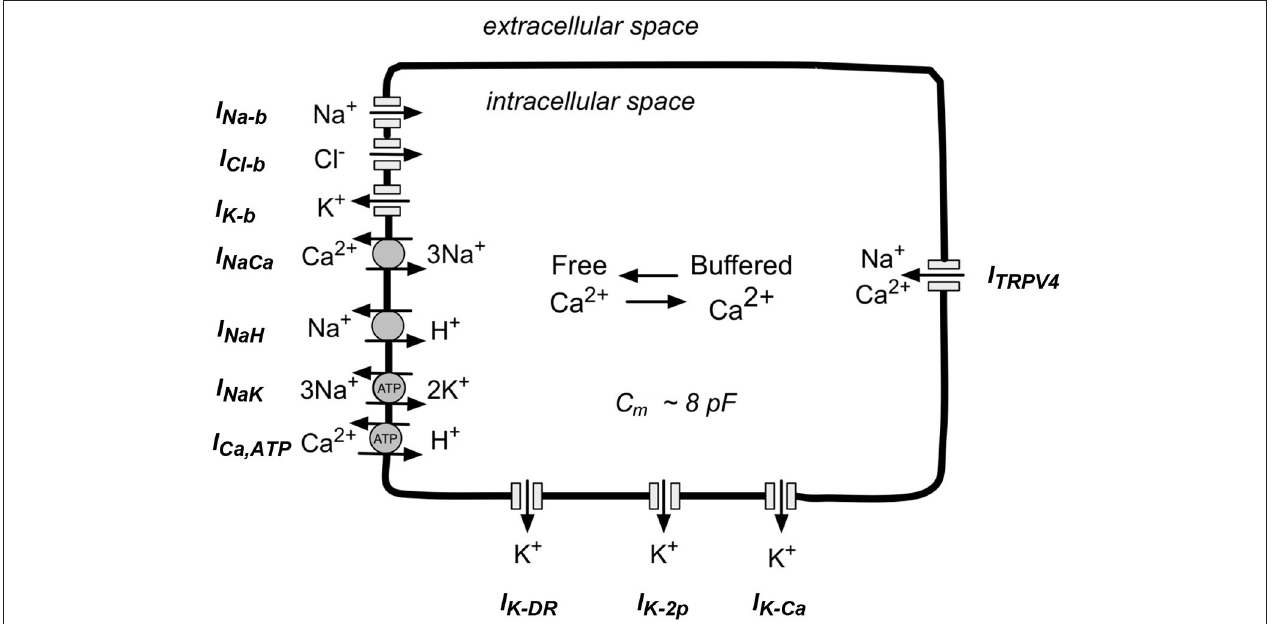
FIGURE 1 | Schematic illustration of the main ion selective channels, ion exchange proteins, and ATP-dependent ion pumps that are known to be expressed in human chondrocytes. This information forms the basis for our mathematical model of chondrocyte K + transport and resting potential, E m . The three ion selective channels labeled at the top left of this diagram are so-called background channels; these currents show no time dependence. The three types of ion channels shown on the bottom are the focus of this paper. These K + -selective channels in human chondrocytes, have been studied in detail in our Laboratory and by other groups (see section Results). The ion-selective pumps and exchangers shown at the bottom left are necessary to maintain volume, and contribute to electrolyte homeostasis in the human chondrocyte. The TRPV4 channels shown on the right can allow Na + and Ca 2 influx. In addition, (see section Discussion) chondrocytes can exhibit + cell-to-cell coupling via connexin-mediated ion and metabolite transfer, and/or “hemichannel behavior” (see section Discussion).